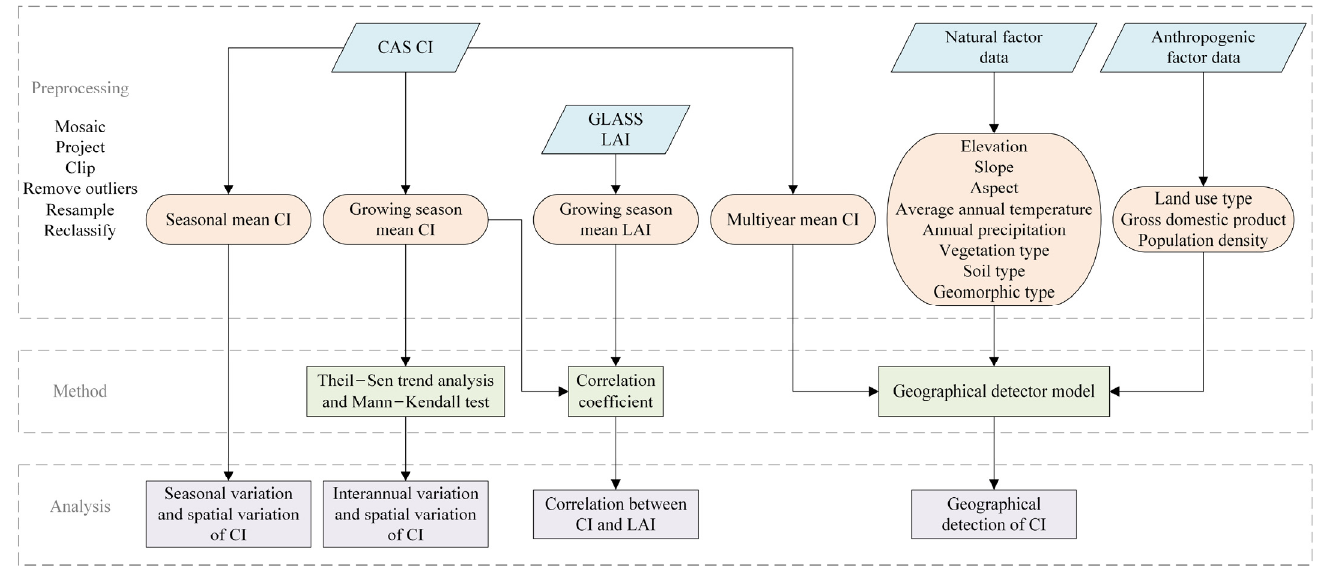
Figure 2. Flowchart of this study.